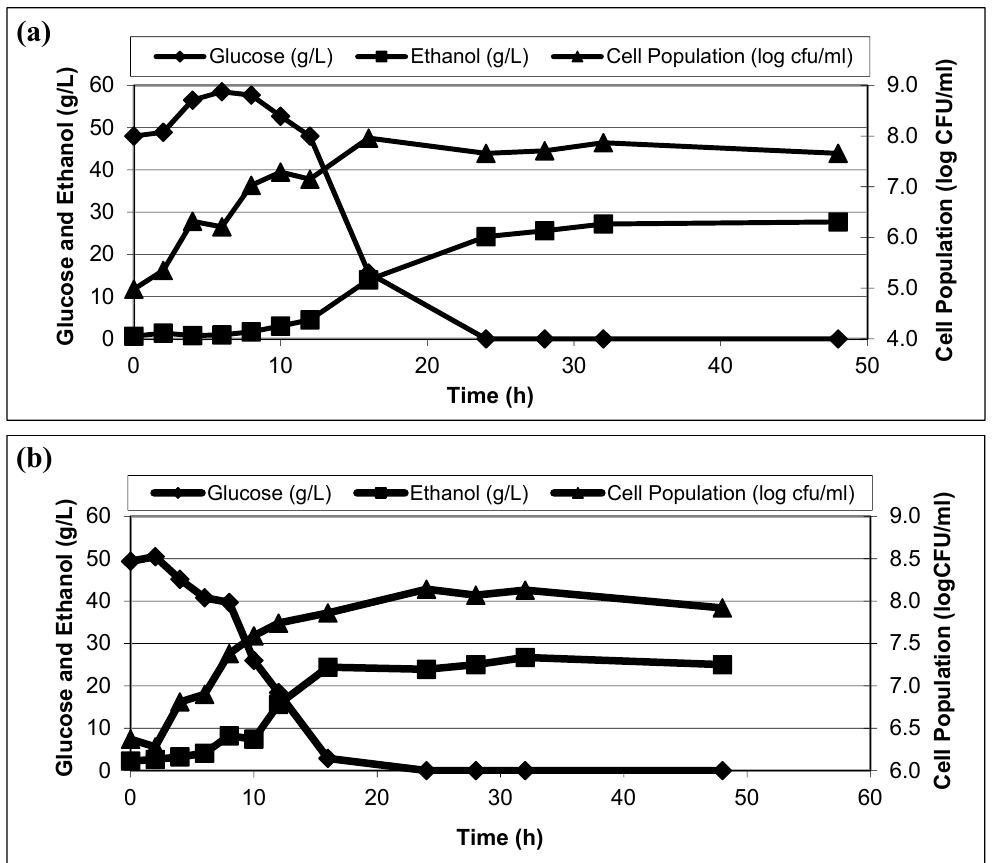
Figure 1. Glucose and ethanol, and biomass concentrations at pH 5.5 ( a ) and uncontrolled pH ( b